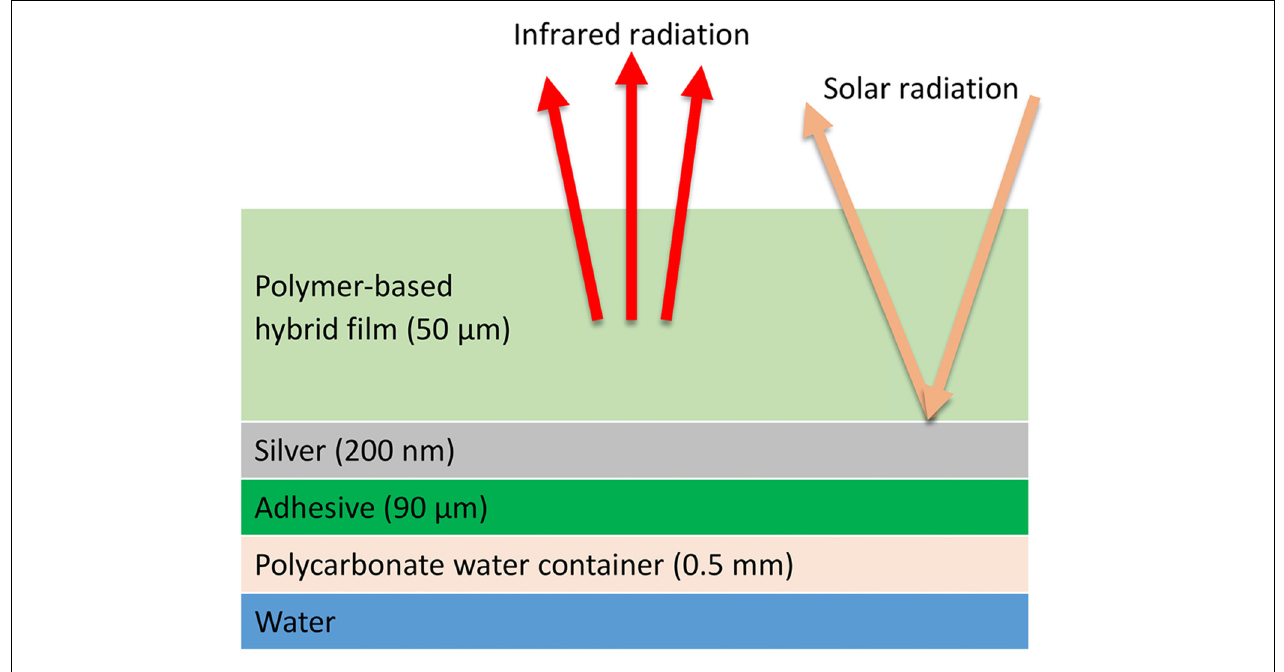
FIGURE 1 | Position of layers in the radiative cooling